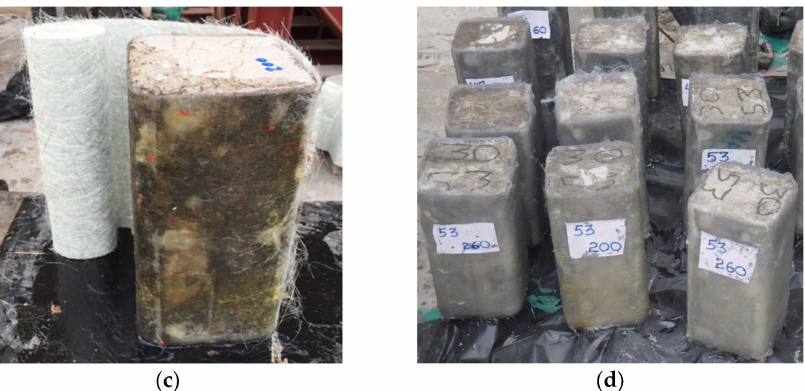
Figure 4. ( a ) Steel molds, ( b ) application of resin using a roller, ( c ) FCSM wrapping in progress, and ( d ) strengthened specimens.